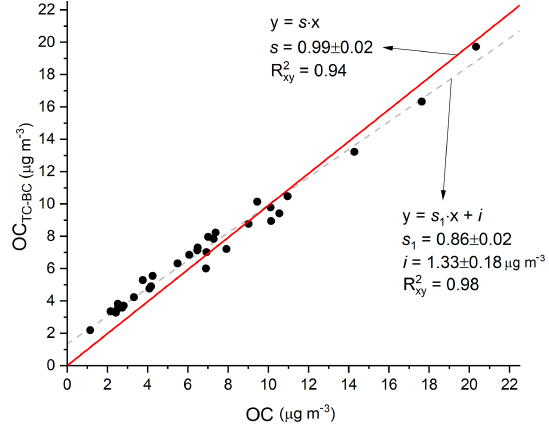
Figure 7. Comparison of offline measurements of EC (laboratory filter analysis) using the EUSAAR_2 thermal protocol to the 24h average of online measurements of BC data taken by the AE33 Aethalometer. Linear orthogonal regression results are shown with s as the slope (red line) for the model without an intercept and with s 1 as the slope and i as the intercept (dashed gray line) for the model with an intercept. R 2 xy is the square of the Pearson correlation coef- ficient. A total of 31 samples were collected for analysis during the campaign.